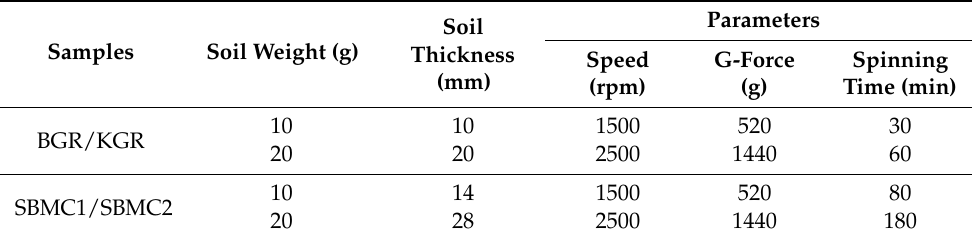
Table 1. Experimental set-up for mini column centrifuge